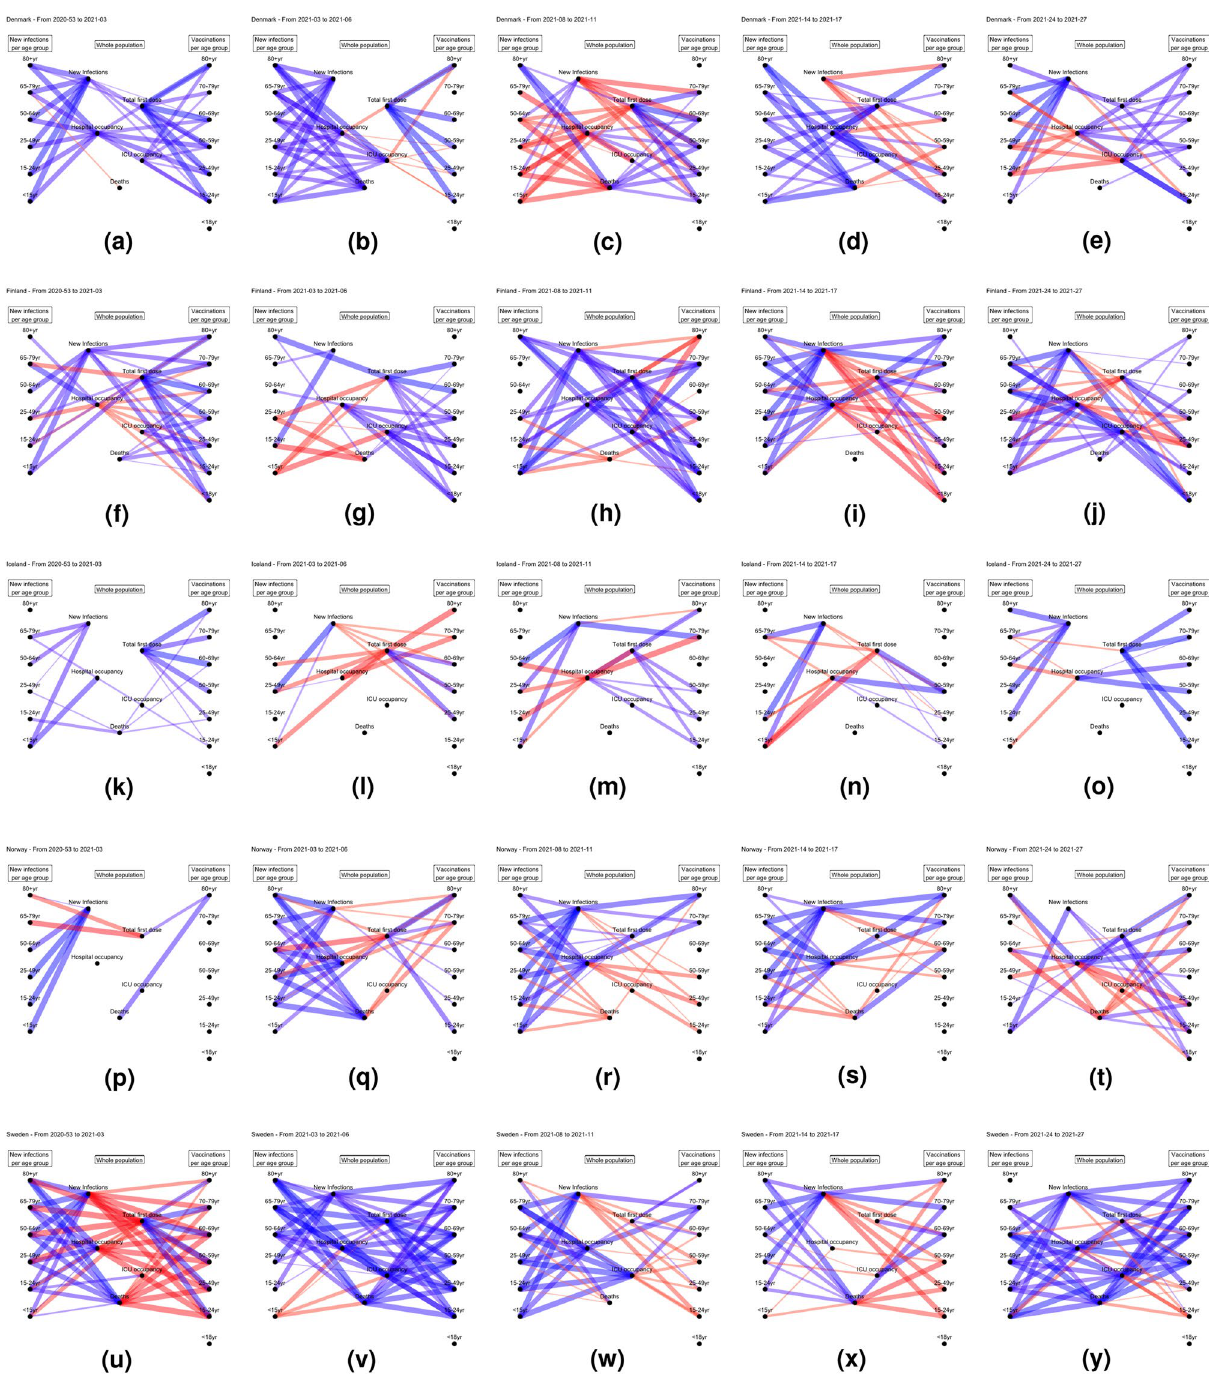
Figure 7. Rolling correlations between changes in population indicators (middle) and infections in age groups (left) and vaccination of age groups (right). Rows from top to bottom: Denmark, Finland, Iceland, Norway, Sweden. Column left to right: From 2020-53 to 2021-03,From 2021-03 to 2021-06, from 2021-08 to 2021- 11,From 2021-14 to 2021-17,From 2021-24 to 2021-27. Blue indicates a positive correlation and red a negative correlation, and a thicker edge indicates a stronger correlation. Correlations with an absolute value below 0.6 are